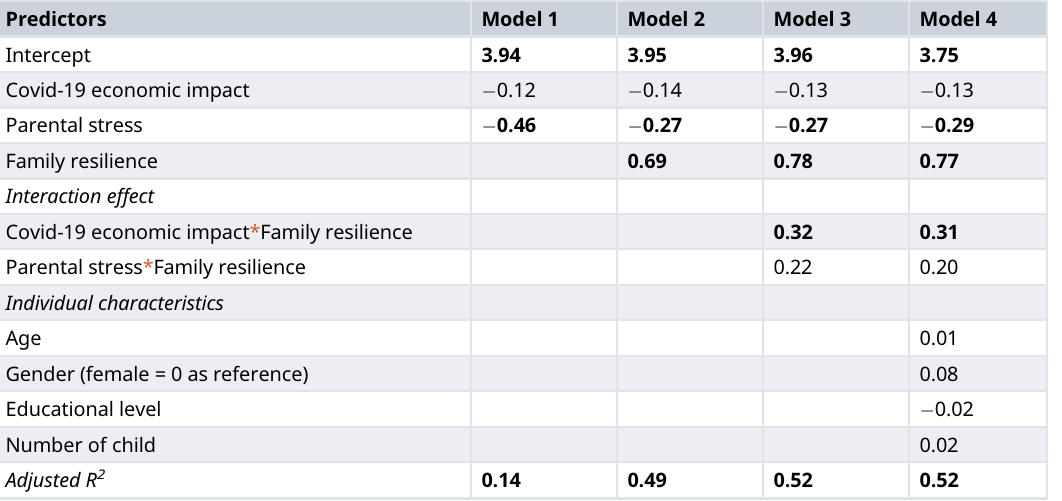
*Bold indicates significance at